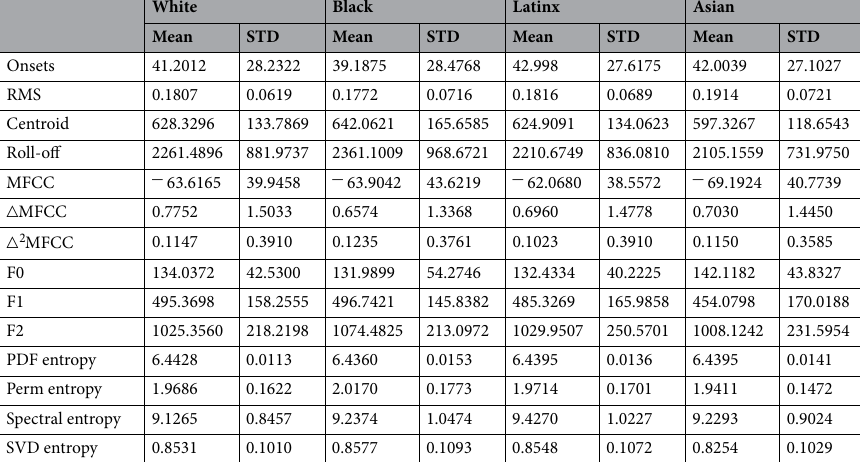
Table 3. Voice fundamental metrics results of racial